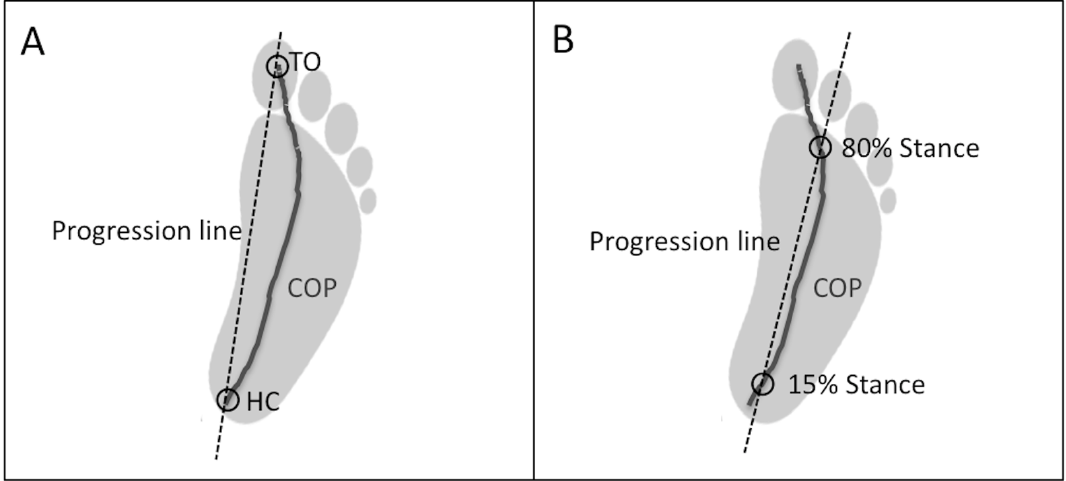
Figure 1. Illustration of the two force-plate methods for estimating the foot progression angle: Method 1 ( A ) and Method 2 ( B ). TO and HC indicate toe-off and heel-contact, respectively.